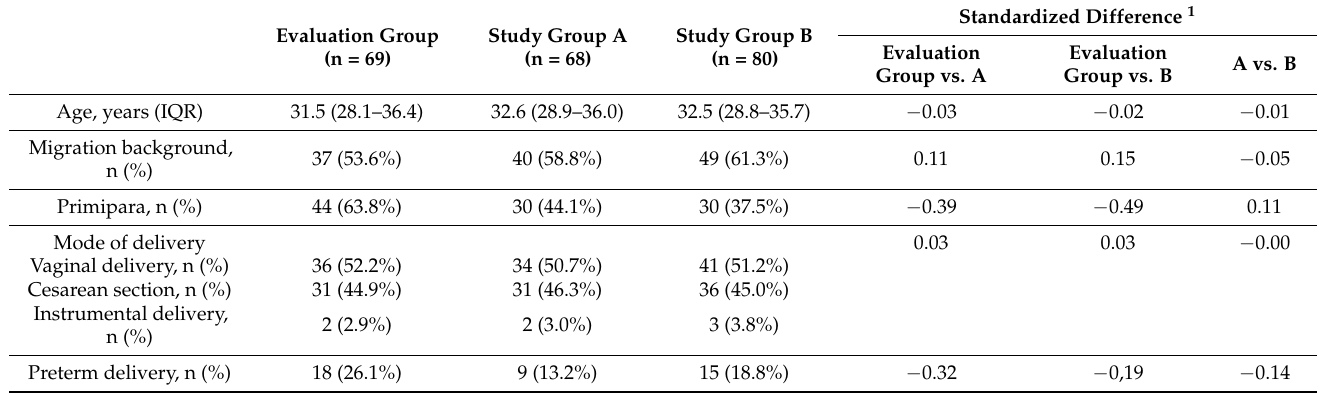
group, as compared to study groups A and B (A: 44.1% vs. B: 37.5% vs. evaluation group: 63.8%; standardized difference—A vs. evaluation group: − 0.39, B vs. evaluation group: − 0.49). The sociodemographic maternal characteristics are shown on Table 1. Table 1. Sociodemographic characteristics of 217 women enrolled in the evaluation group and the study groups A and B.